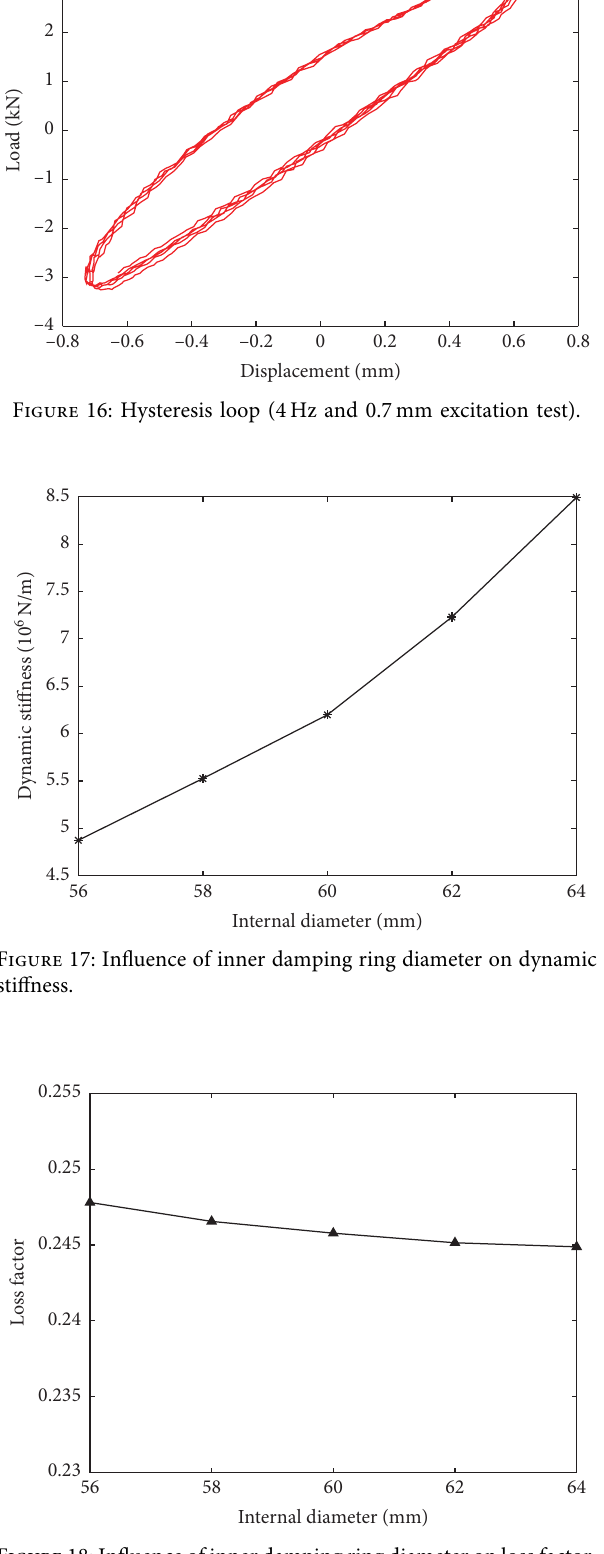
Figure 18: Influence of inner damping ring diameter on loss